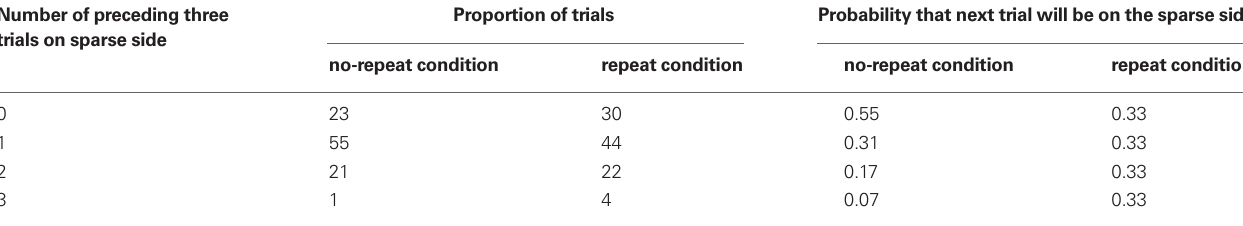
Table 2 | results of simulation of the repeats and no-repeats sequences in Walthew and gilchrist (2006). Note that for nearly one-quarter of the no-repeat condition, the next trial is actually more likely to be